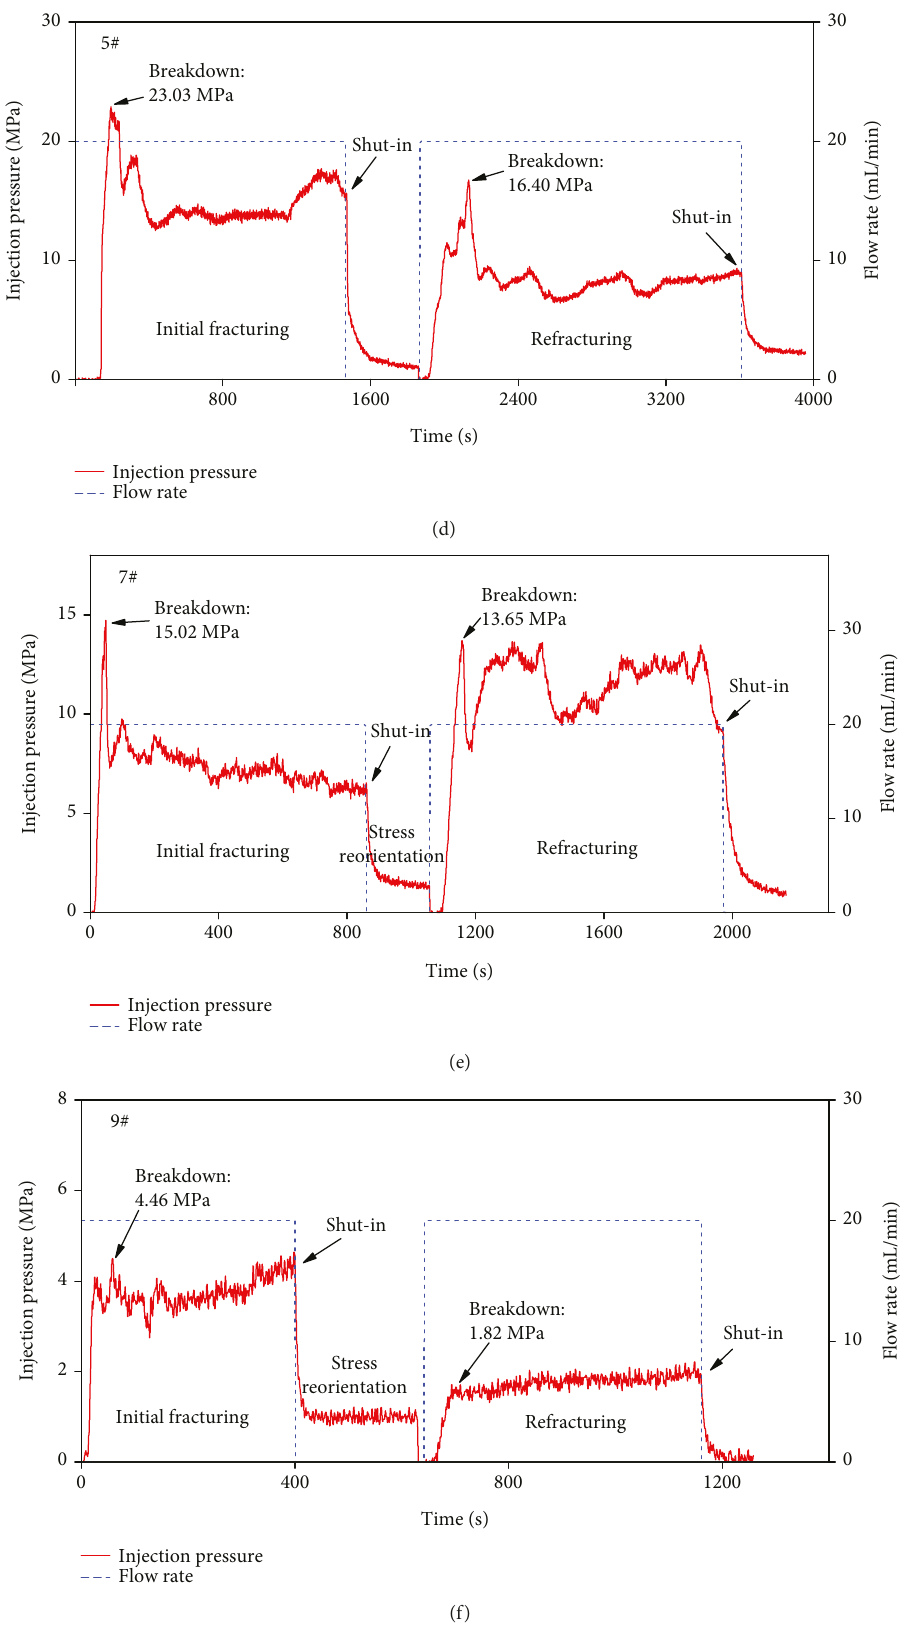
Figure 6: Injection pressure curves for refracturing